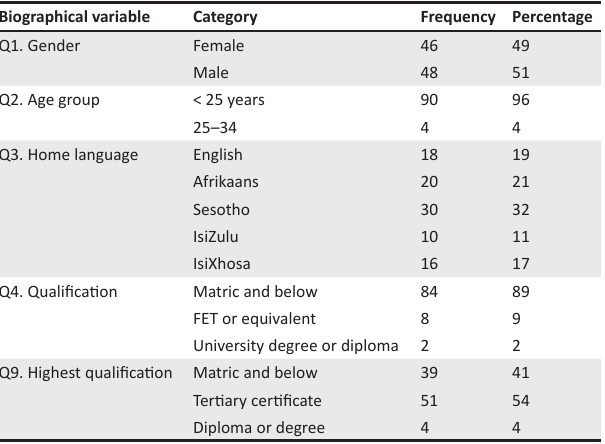
TABLE 2: Biographical information for